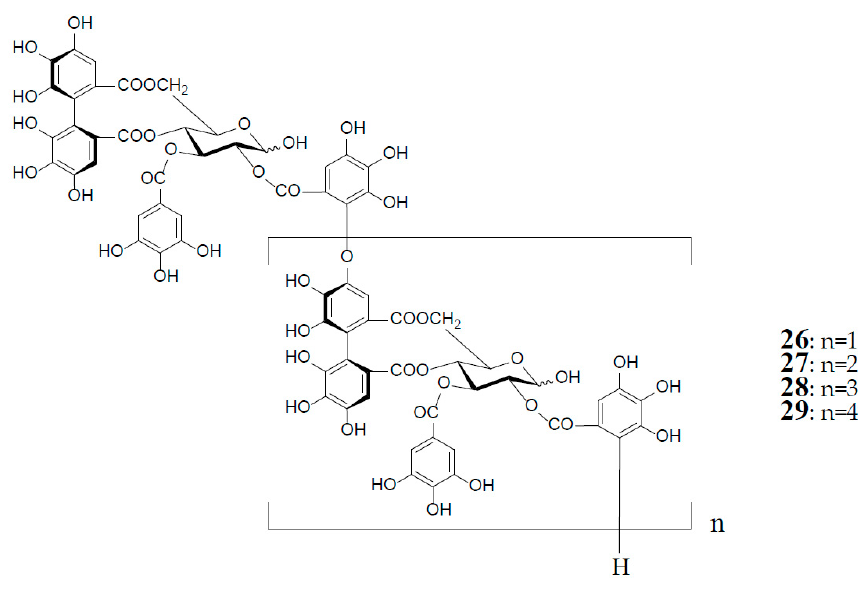
Figure 6. Structures of eucalbanin B ( 26 ), eucarpanin T 1 ( 27 ), pomegraniin A (tetramer) ( 28 ), and B (pentamer) ( 29 ).